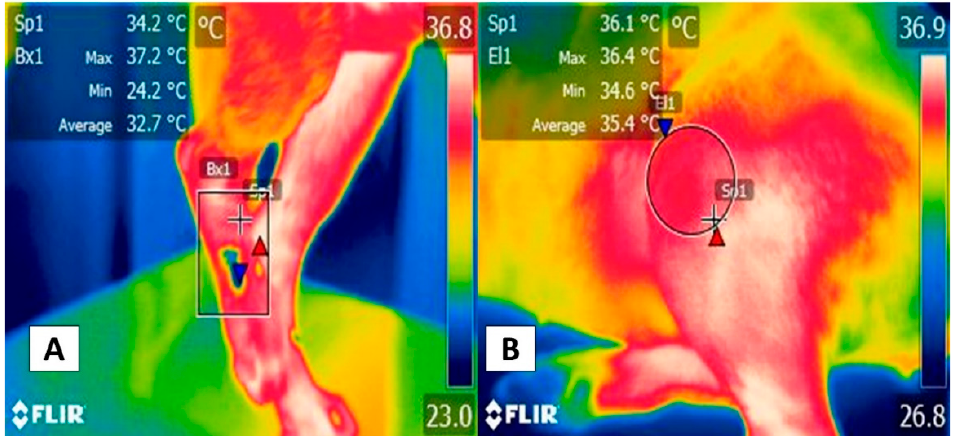
Figure 4. Modified thermal windows in forelimbs and hindlimbs for complementary diagnoses of inflammatory pathologies: ( A ) Complementary diagnosis of a metacarpal fracture. The rectangular figure (Bx1) shows a significant temperature increase in the metacarpal region of the right pelvic limb with a maximum of 37.2 °C (red triangle) and a minimum of 24.2 °C (blue triangle). This was associated with a fracture of the metacarpal bones in a 4-year-old male boxer dog. It is important to note the minimum temperature reduction, which could be related to a lack of local circulation produced by the destruction of surface blood vessels. In contrast, the maximum temperature is associated with the inflammation of peripheral tissues. ( B ) Complementary diagnosis of articular pathologies. The circular figure (El1) shows the significant increase in temperature with a maximum of 36.4 °C (red triangle) and a minimum of 34.6 °C (blue triangle) in the tibia-femoral-patellar joint of a male Pitbull dog with a cranial cruciate ligament rupture, manifesting a <3 C° limp or surrender, in the left pelvic limb. Both cases show that IRT can provide a comple- mentary, non-invasive method that aids in initial approaches to patients that have suffered trauma. Sp1: default focal point of the software. Thermal images obtained using a FLIR thermal camera.